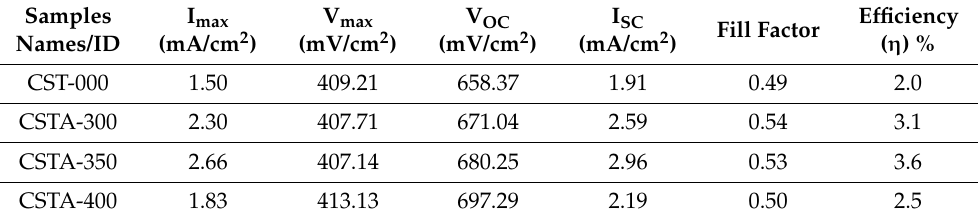
Table 1. PEC parameters like open-circuit voltage (V OS ), short-circuit current (I SC ), fill factor (FF), and efficiency ( η ) of as-prepared and air-annealed samples at different annealing